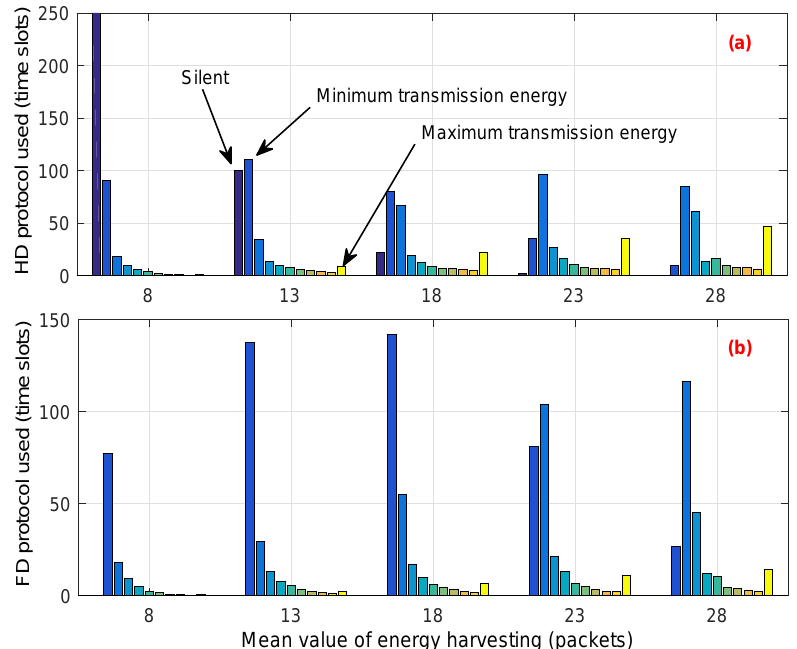
Figure 10. Statistics on the conventional scheme: average number of time slots where the CU decides to transmit using the ( a ) half-duplex (HD) or the ( b ) full-duplex (FD) protocol with the corresponding amounts of transmitted